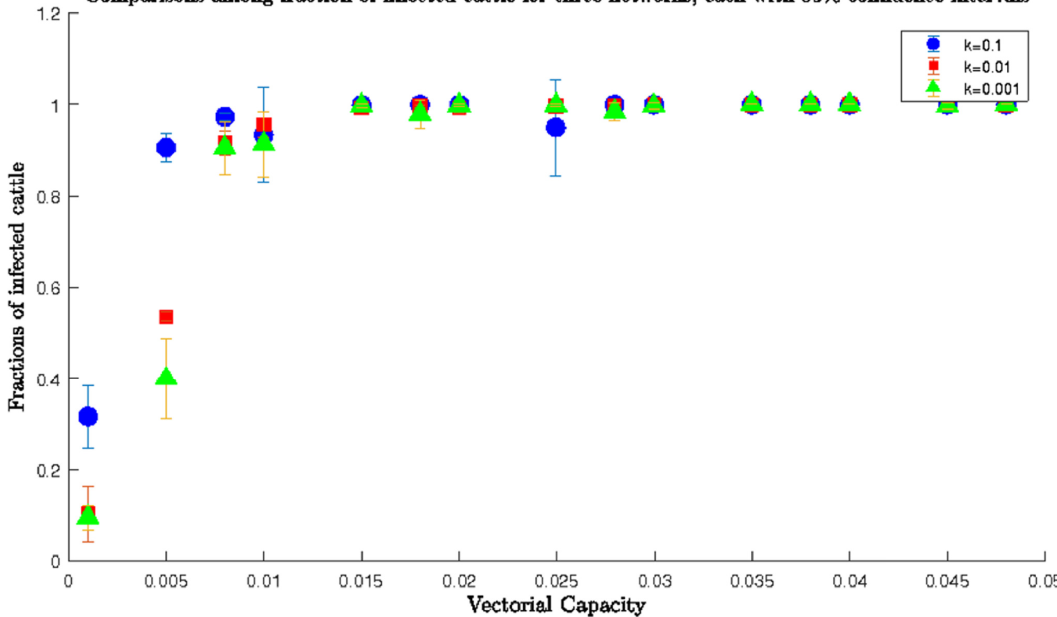
Fig 5. Comparisons among fractions of infected cows for homogeneous network for three different values of k and upper range of β ; fractions of infected for all three values of k were almost overlapping, therefore, not sensitive to the movement probability. They reached a value very close to one, i.e., the whole network became infected when transmission rate β reached 0.01 for the three networks. Therefore, fractions of infected cows were also independent of the transmission